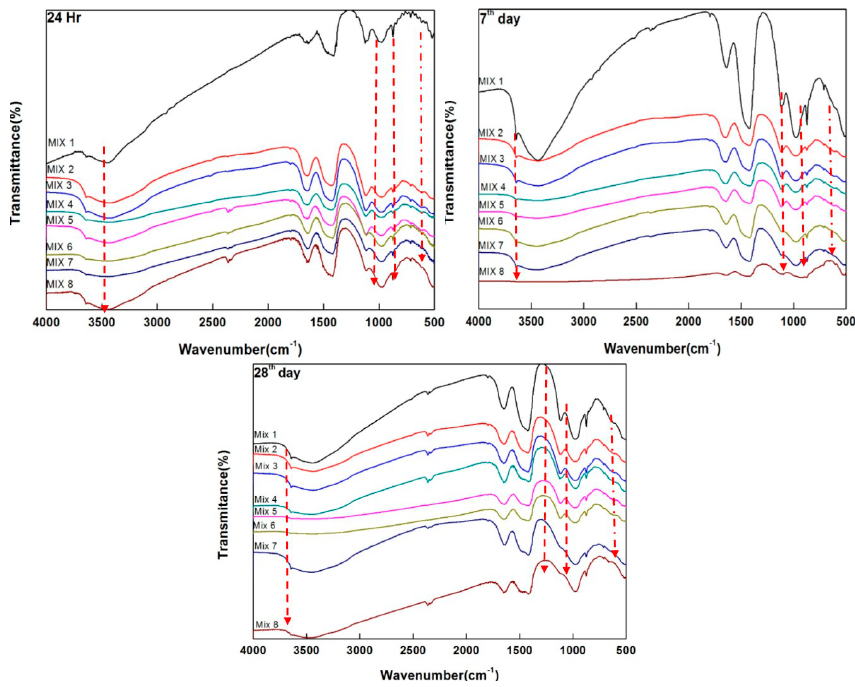
Figure 4. FT-IR spectra of hydration of all Mixes during various hydration intervals.